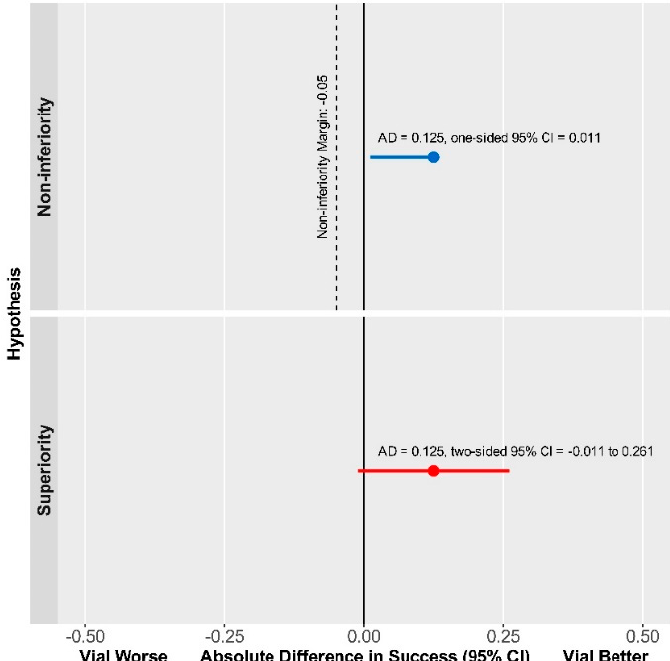
Figure 3. The Vial technique is non-inferior compared with Dedicated Device with respect to DOCE.